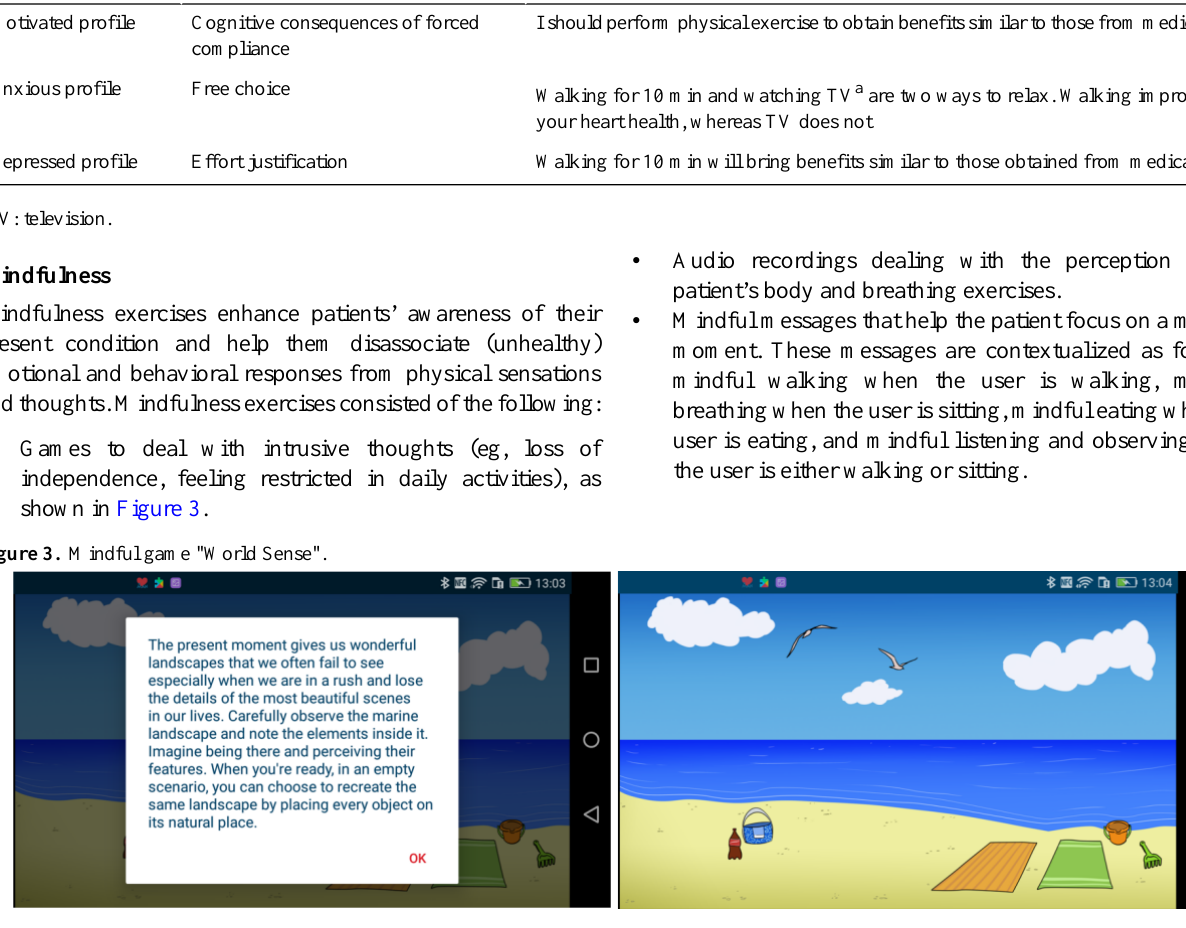
Example messageFestinger principlePsychological profile